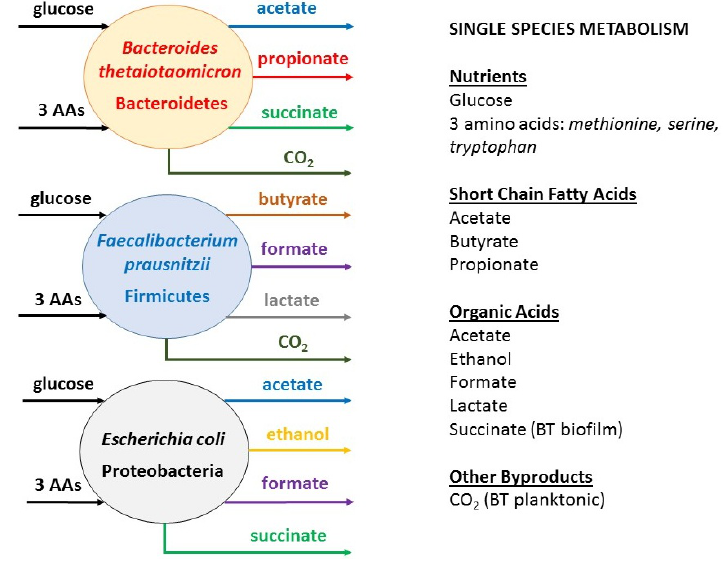
Figure 1. Secreted byproducts predicted by metabolic reconstructions and biofilm metabolic models of the three individual species. The same byproducts were predicted for planktonic and biofilm growth with the exception of B. thetaiotaomicron , for which CO 2 was produced only planktonically and succinate was produced only in the